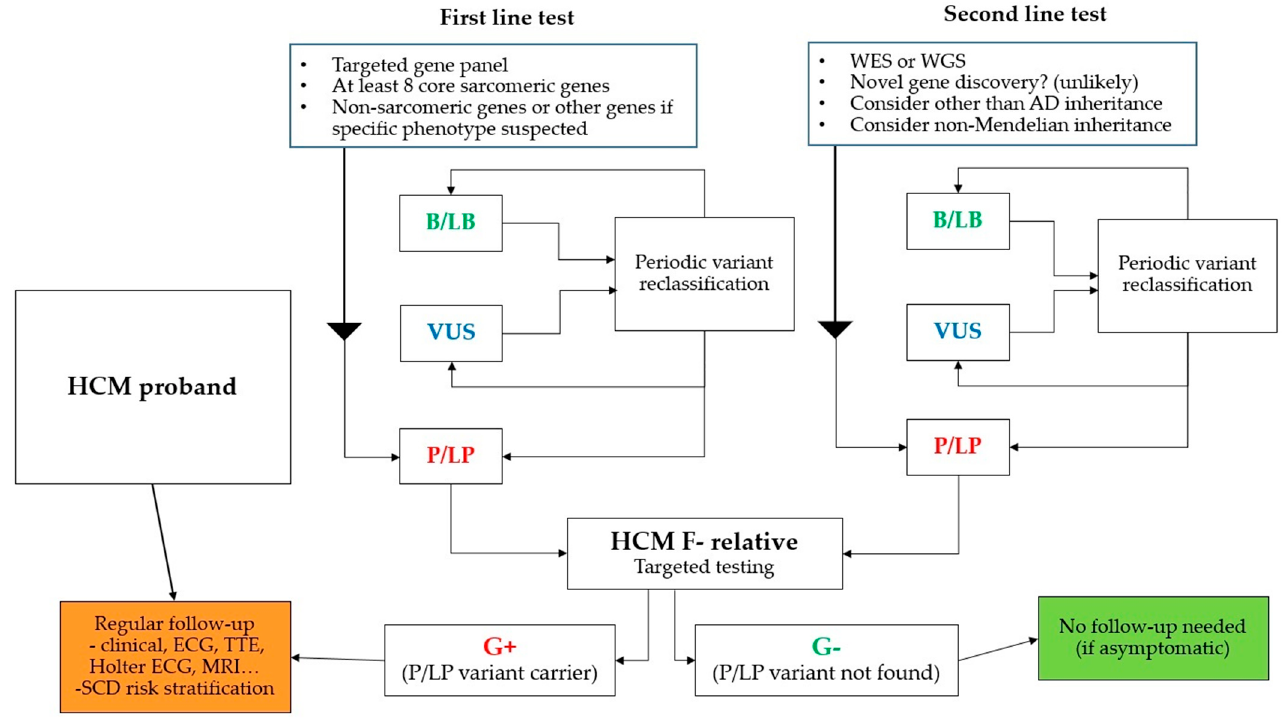
Figure 1. Cascade genetic testing. B/LB—benign or likely benign, P/LP—pathogenic or likely pathogenic, VUS—variant of unknown significance, WES—whole exome sequencing, WGS—whole genome sequencing, ECG—electrocardiography, MRI—magnetic resonance imaging.